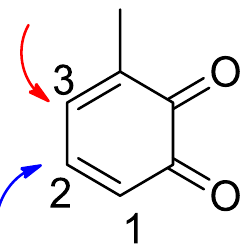
Figure 5. Regioselectivity of the laccase-catalyzed reaction between 3-methyl catechol 3b and 2e , 2 k.